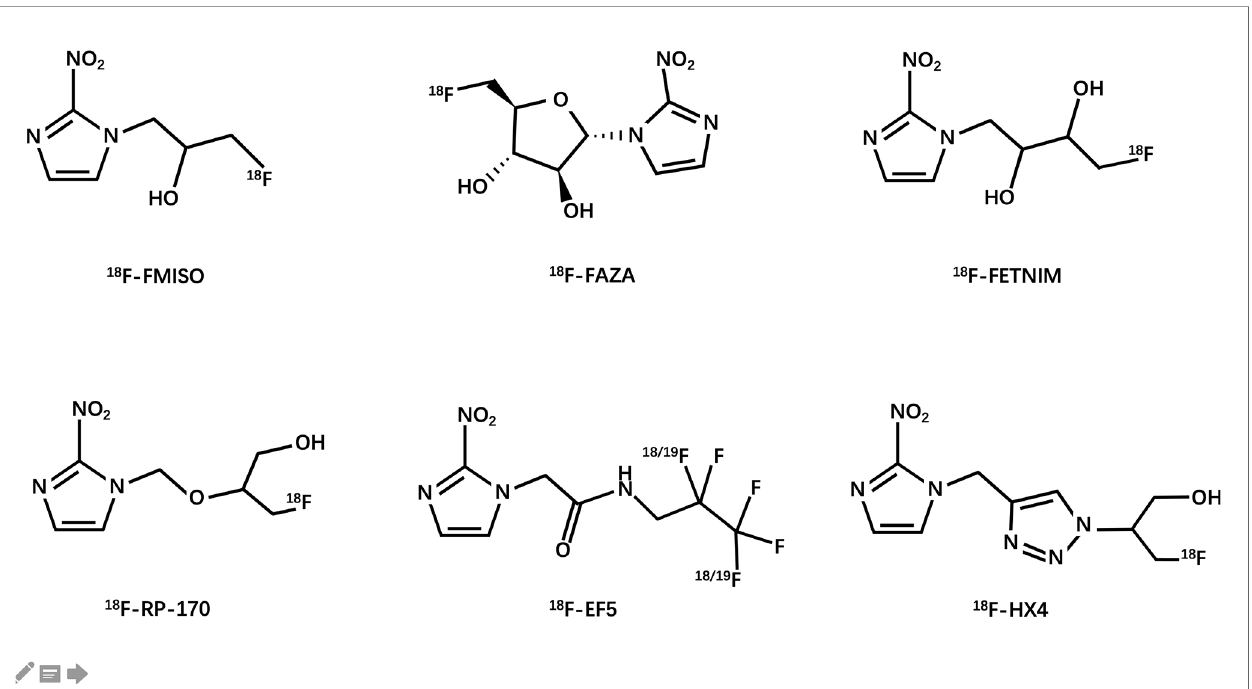
FIGURE 3 | Structures of clinically used [ 18 F]-labeled nitroimidazole compounds.